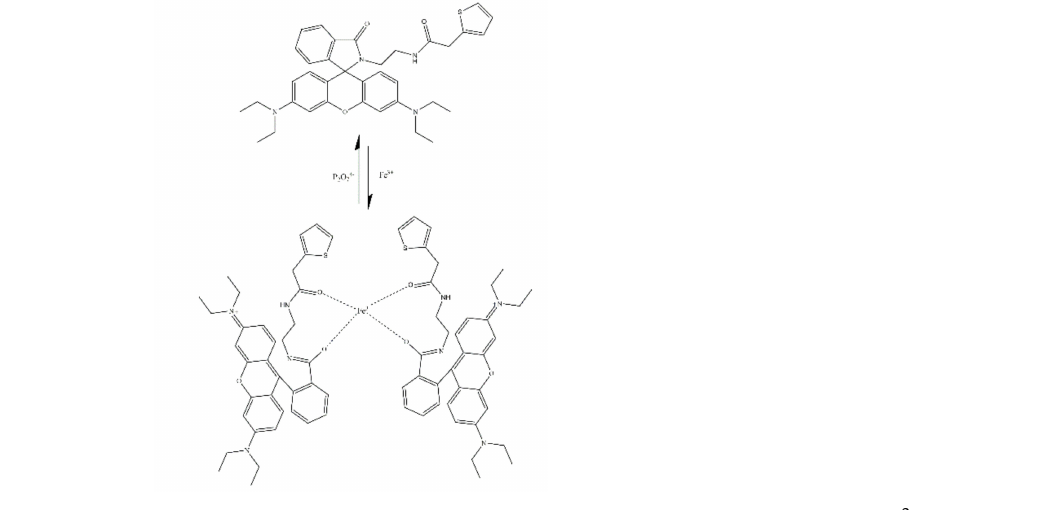
Figure 21. The proposed sensing mechanism of BYY (Table 1, No. 27) for Fe 3+ [56]. Wang, Y., et al. designed a simple rhodamine-based fluorescent and colorimetric sensor, L1, exhibiting a good selectivity and sensitivity to Fe 3+ (Table 1., No. 28) [57]. The detection limit of the L1 sensor was 0.29 × 10 − 6 M. The sensing process, which was shown in Figure 22, was chemically reversible at least three times on the alternate addition of AcO − and Fe 3+ .